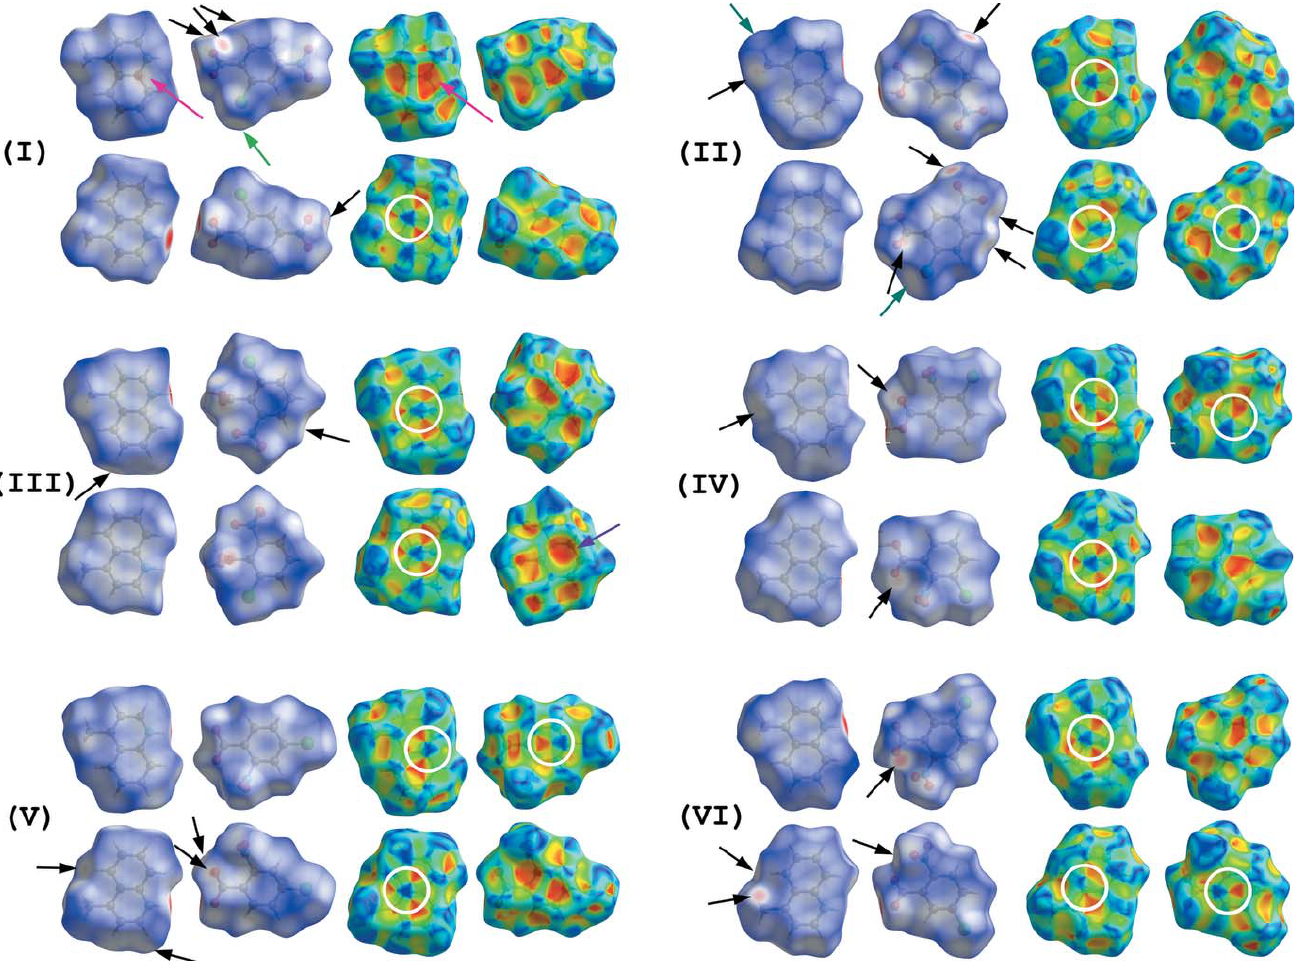
Figure 12 Hirshfeld surfaces [front (top) and back (bottom) views] for compounds (I)–(VI) mapped over d norm and shape index. Each surface is viewed approximately perpendicular to the molecular plane. The (cid:2) – (cid:2) interactions are shown by white circles, and the Cl (cid:2)(cid:2)(cid:2) Cl contacts, the C—H (cid:2)(cid:2)(cid:2) O, C— H (cid:2)(cid:2)(cid:2) Cl, N—O (cid:2)(cid:2)(cid:2) (cid:2) and C—H (cid:2)(cid:2)(cid:2) (cid:2) interactions are indicated by green, black, green cyan, magenta and violet arrows,